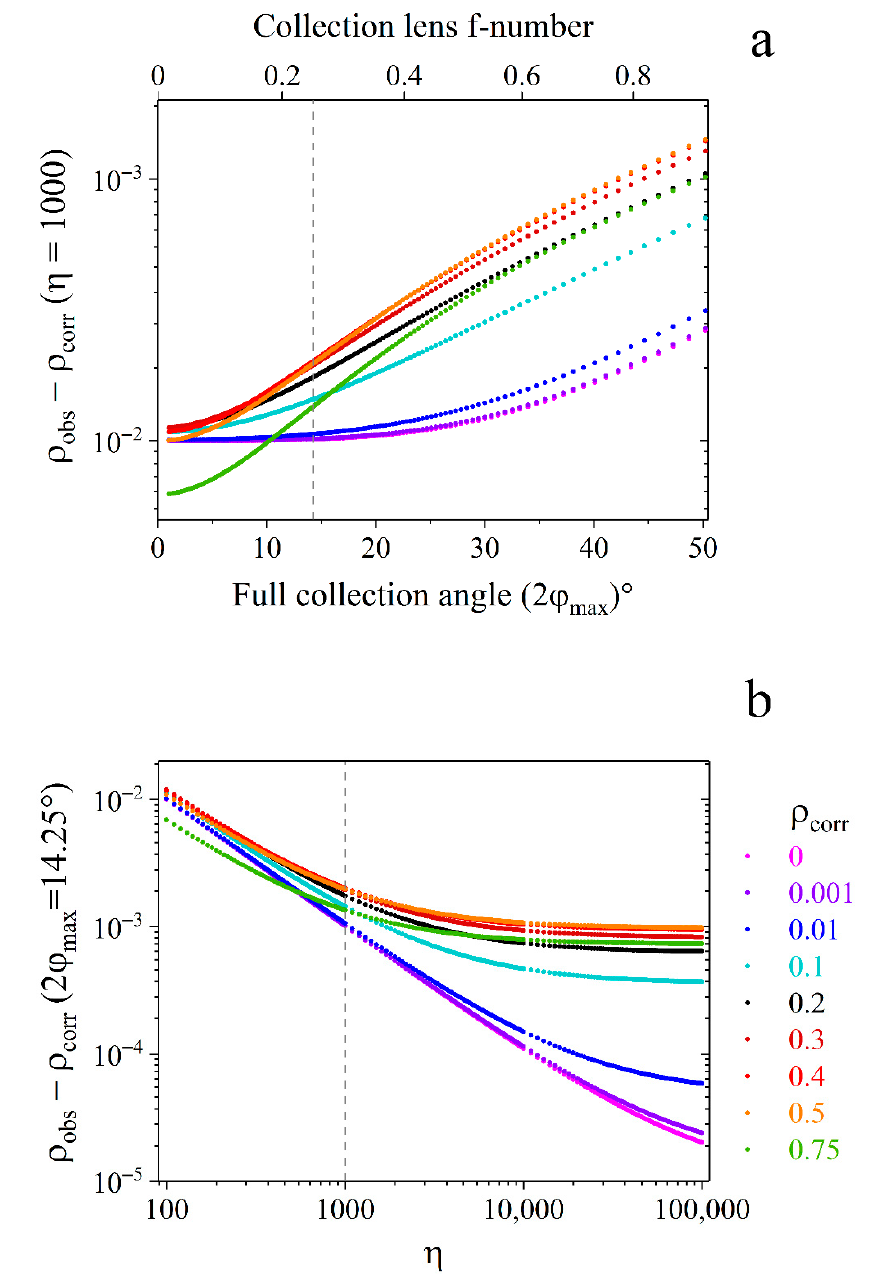
Figure A2. Deviation of the observed depolarization ratio from the corrected one as a function of the total collection angle 2 φ max ( a ) and the parameter η ( b ), calculated using Equations (A13) and (A16)–(A25). The dashed line denotes the boundary values of the angle 2 φ max = 14.25° (lens f/4) and the parameter η = 1000, corresponding to the experimental setup used in this work.